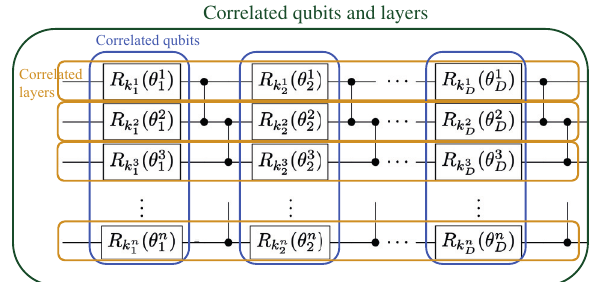
FIG. 2. Ansatz employed in numerical simulations. The ansatz is composed of alternating random single-qubit rotations and lad- ders of CPHASE operations. The colored boxes indicate the gates, which are fixed to rotate by the same angle and in the same direc- tion when we correlate the ansatz layers (yellow), correlate qubits (blue), and correlate both the layers and qubits